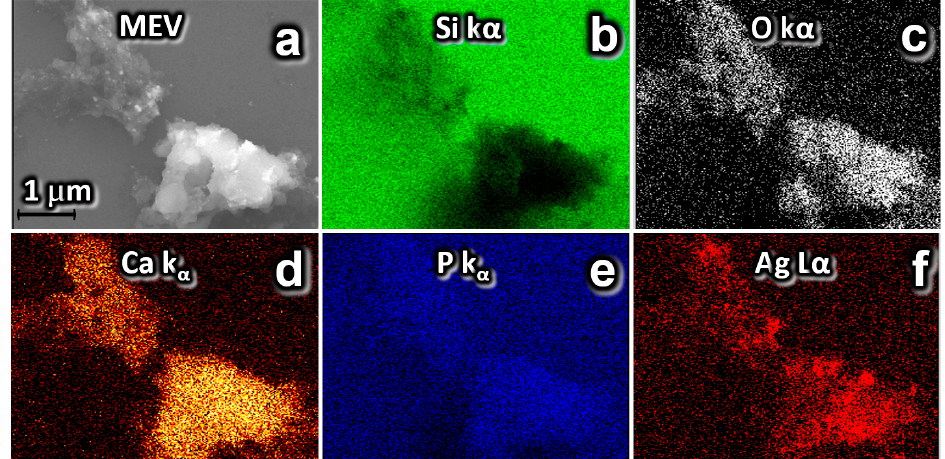
Figure 4. SEM and EDS mapped in 2D elements issuance Si K α , O K α , P K α , Ca K α , and Ag K α false color. Analysis of the distribution of silver nanoparticles on the Ag-CaGP for sample C4: ( a ) SEM image; ( b ) chemical mapping of silicon element present in the substrate, where the electron beam was focused directly on the substrate and is showed in green color, and the dark regions the beam was focused in Ag-CaGP nanocomposite C4; and, ( c – f ) oxygen, calcium, phosphorus, and silver, respectively, demonstrating they are constituents of the Ag-CaGP.